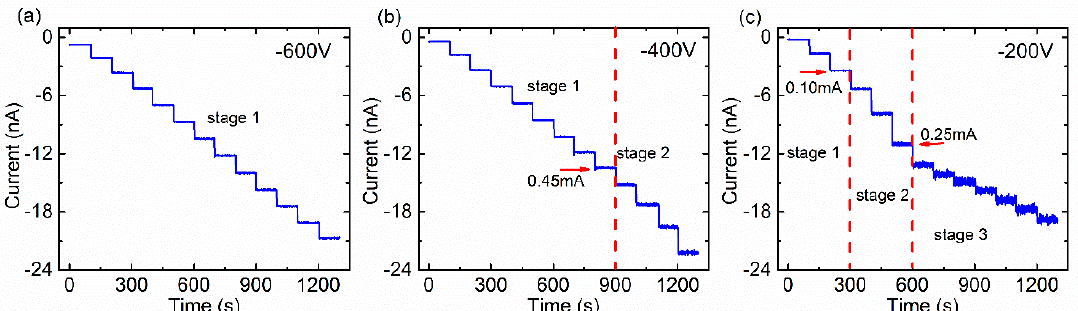
Figure 4. The X-ray photocurrent vs. time at the: ( a ) − 600 V, ( b ) − 400 V, ( c ) − 200 V applied bias. The tube current varied from 0 mA to 0.6 mA, stepping 0.05 mA per 100 seconds. The X-ray tube voltage was set at 80 kV.